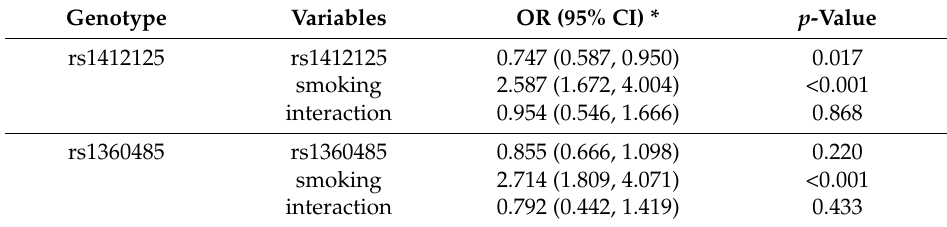
Table 7. Logistic model of multiplicative interaction between SNPs and tobacco exposure.